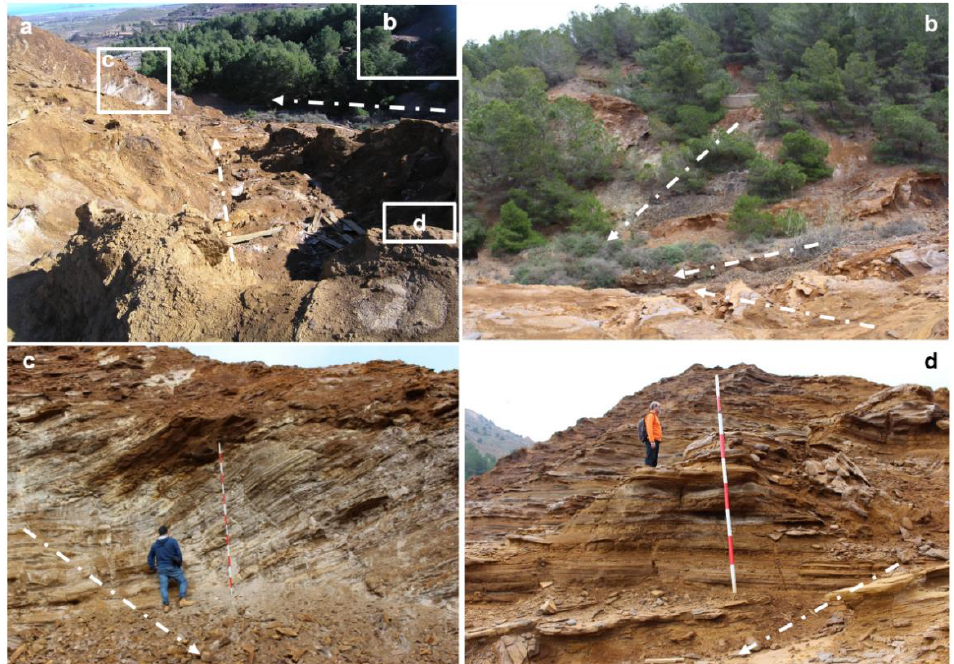
Figure 10. ( a ) View of landslide three (LL3) from lagoon one (Lg1). ( b ) View of the dam slide deposit remnants on the opposite stream bank, which caused the stream obstruction. ( c ) View of the tilted tailings bedding in the right margin of the landslide LL3, which is in contrast with the subhorizontal bedding of mining tailings. ( d ) View of the almost horizontal bedding characteristic of the tailings deposition, in the left margin of the landslide. The discontinuous arrow indicates the direction of the runoff.